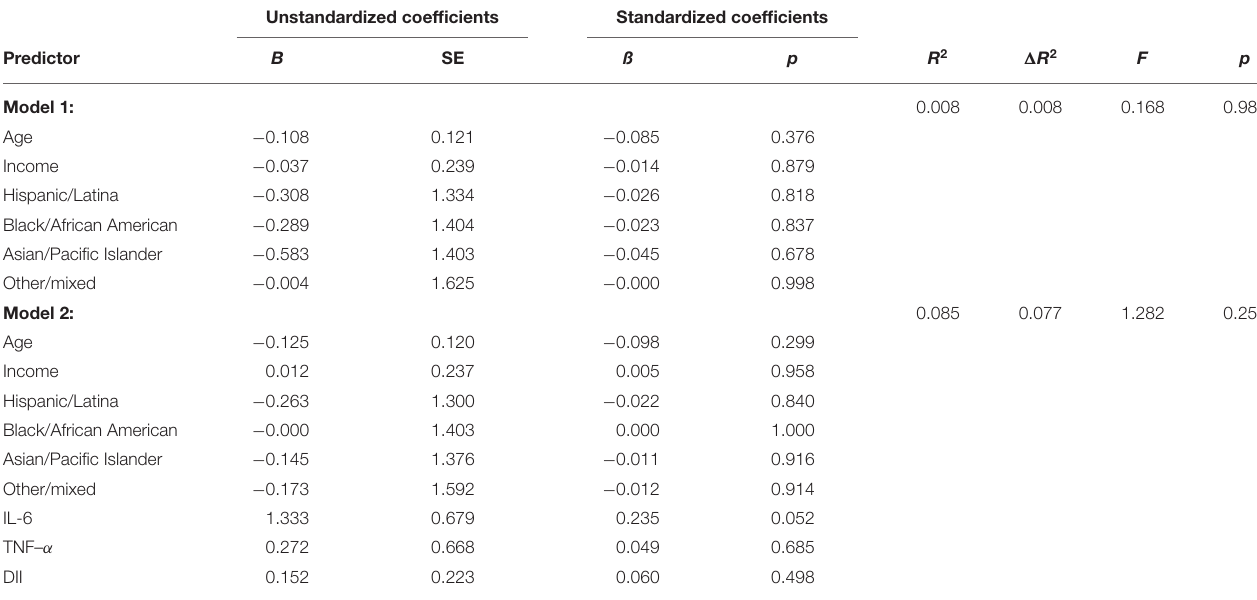
TABLE 4 | Summary of multiple regression analysis examining the adjusted relationship between inflammation variables and the somatic